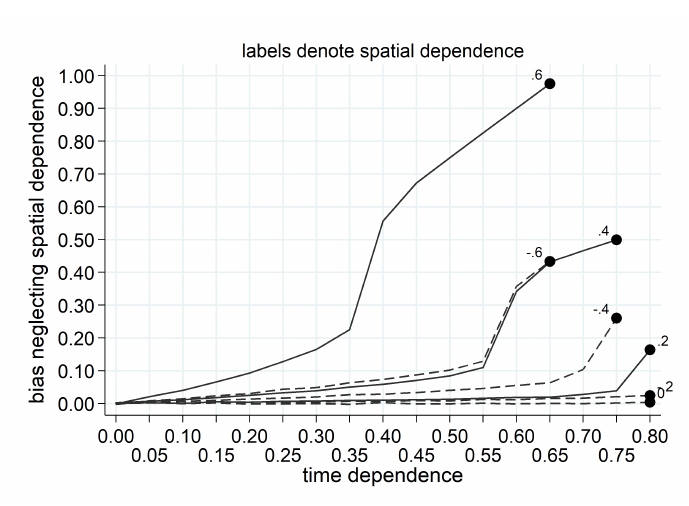
Figure E.5: Bias of Team Dynamic neglecting the spatial dimension. The vertical axis describes γ TD − γ 0 , the horizontal axis depicts γ 0 . Labels denote spatial dependence in the DGP ( λ 0 ). Based on row-normalized spatial weights matrix.